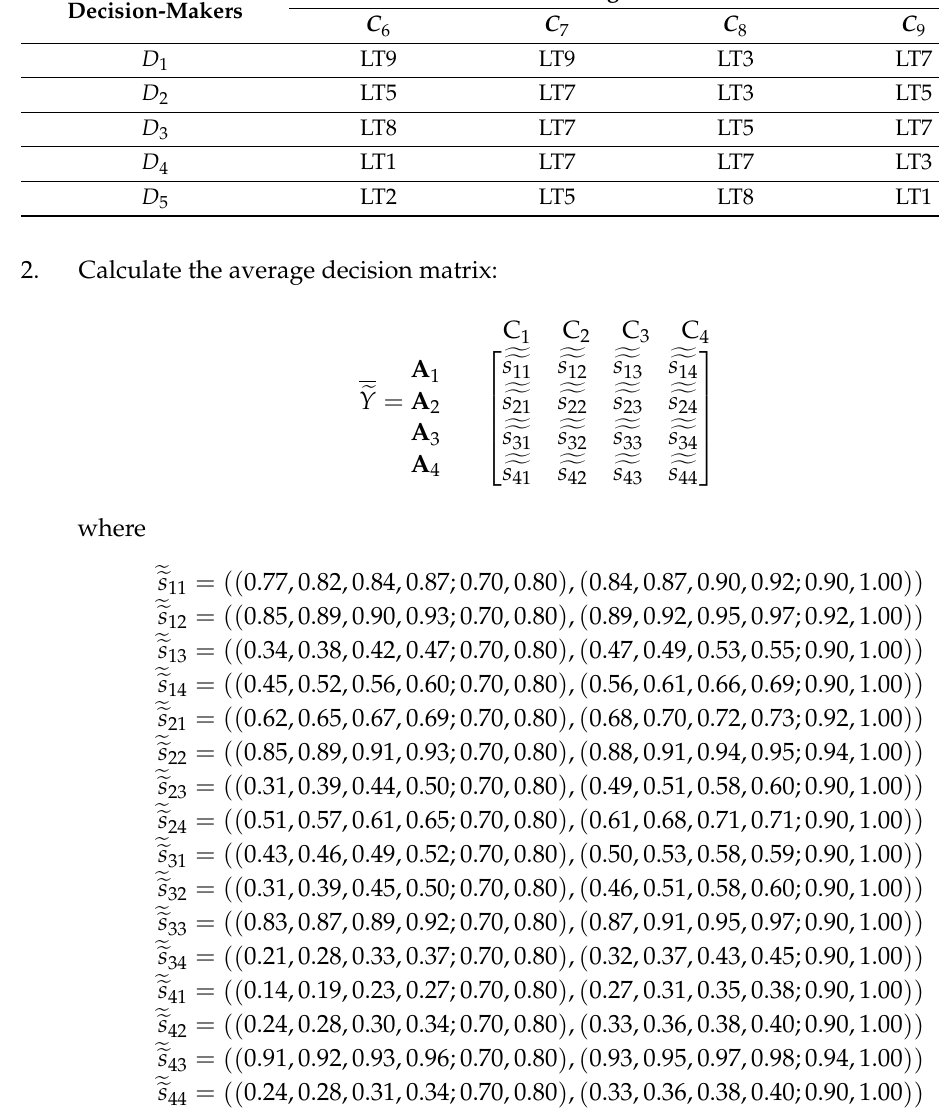
Table 6. Social factors weights of the criteria assessed by the decision-makers.